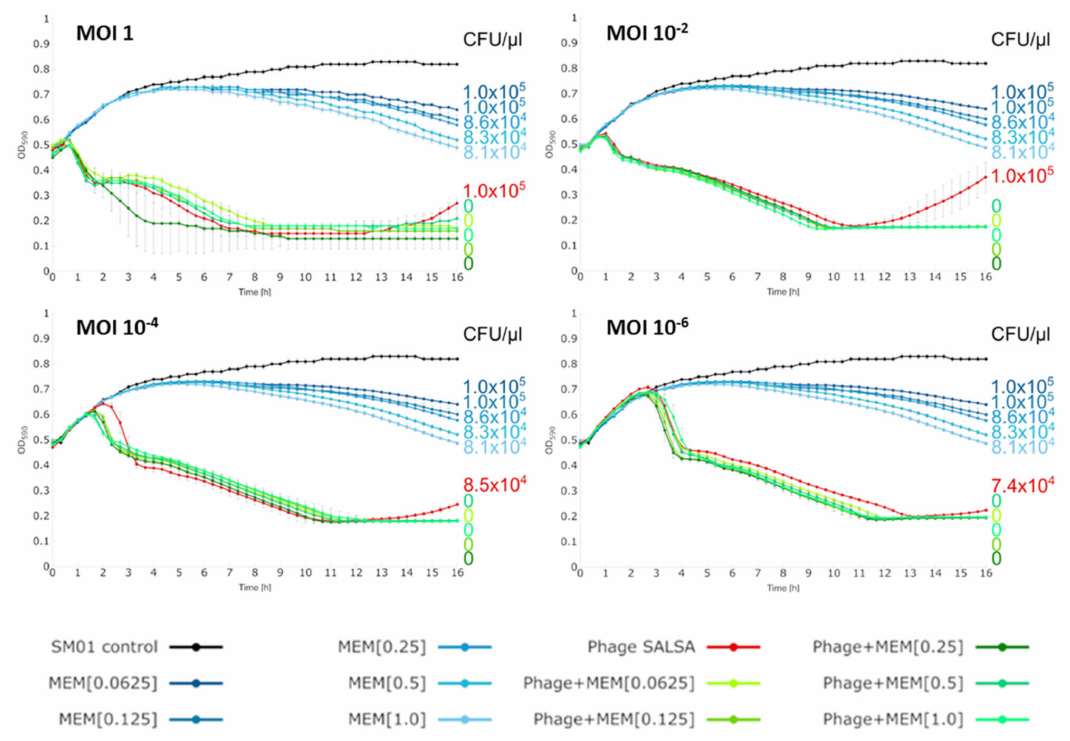
Figure 5. Liquid infection assays against S. marcescens strain SM01 with or without various concentrations (mg / L) of the antibiotic meropenem (MEM). Reduction was measured via optical density at 590 nm (OD 590 ). Each experiment was performed in triplicate and the means ± standard errors are indicated. The number of colony forming units / µ L (CFU / µ L) after 16h is given on the right side. Data are from one set of experiments but are shown in four graphs for better visibility of the phage / antibiotic